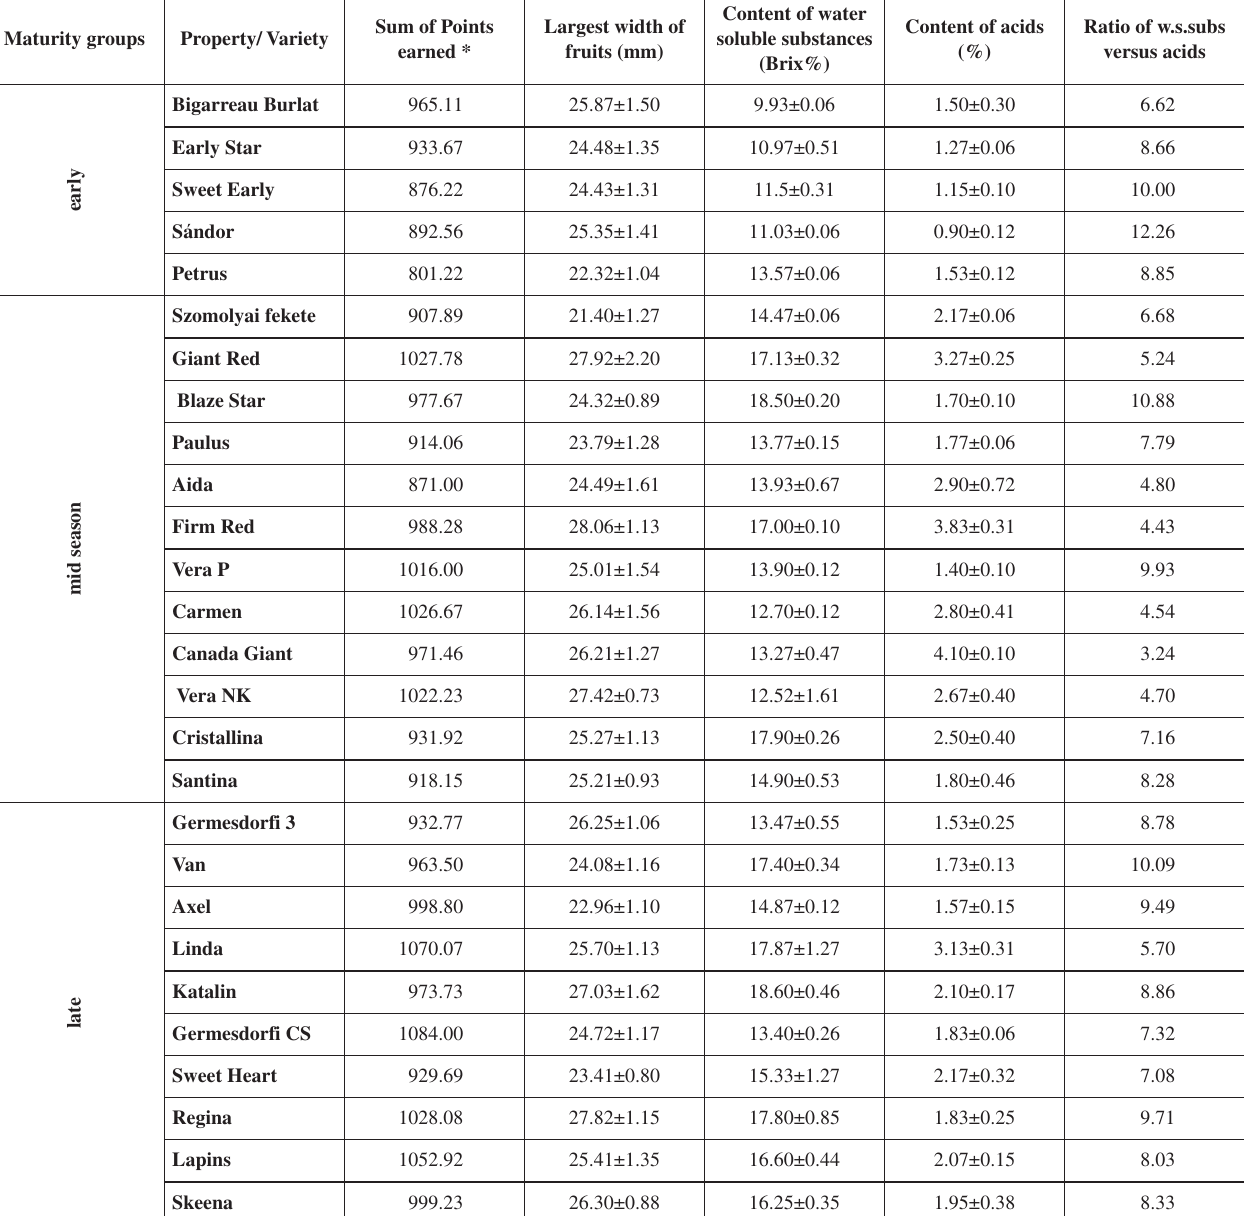
* maximum of points 1200, it is the product of 12 properties with maximum 100 points each